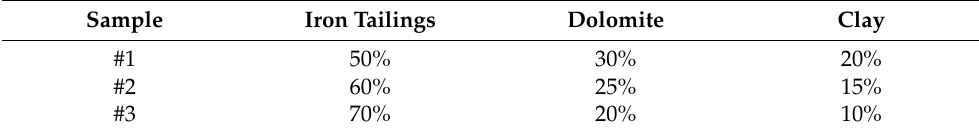
Table 3. Raw material preparation scheme of Si-Ca-based